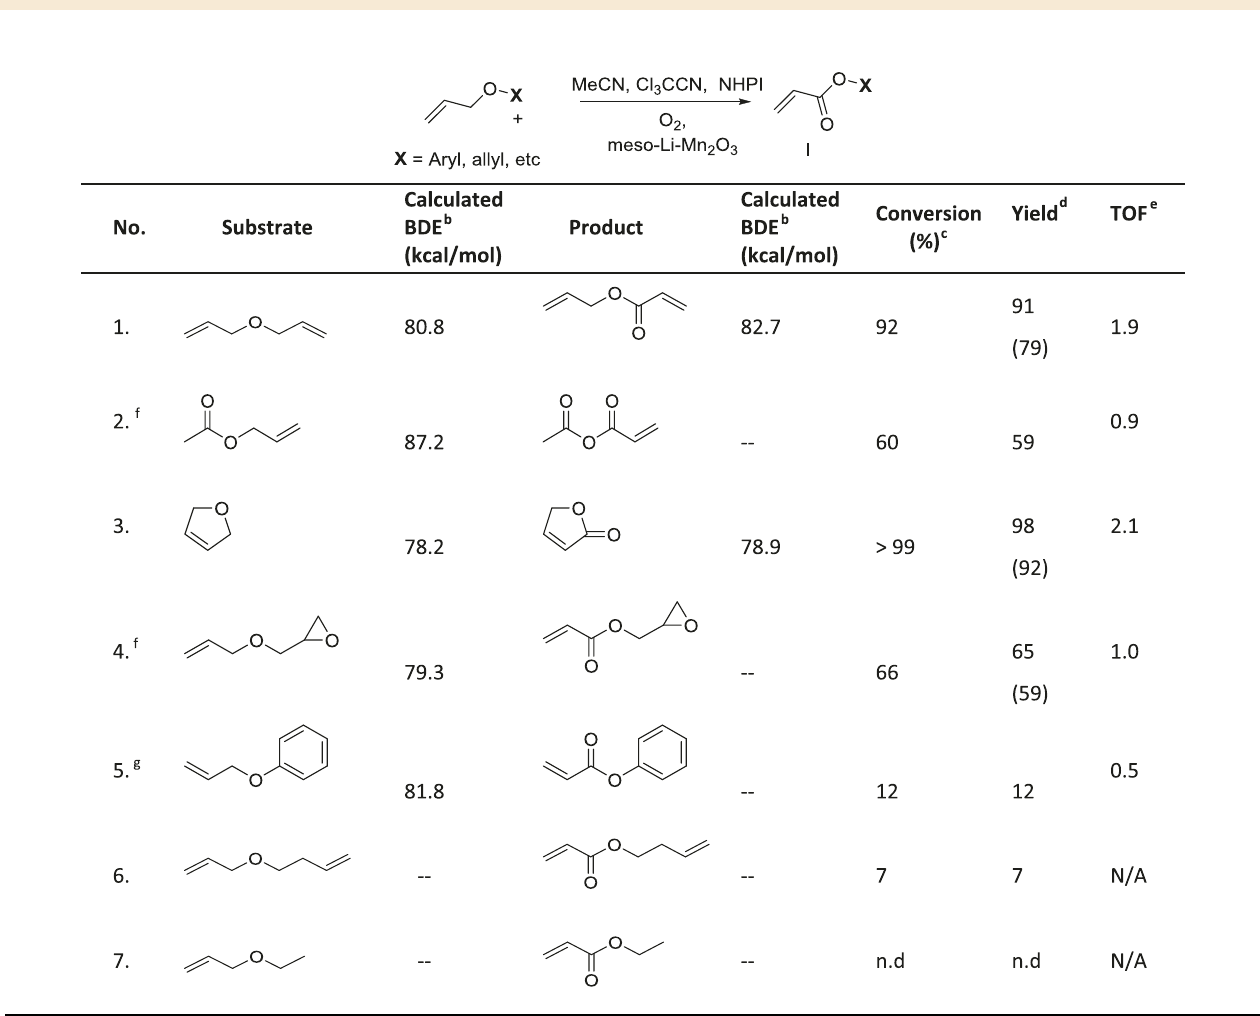
Table 1 Substrate scope of the reaction protocol